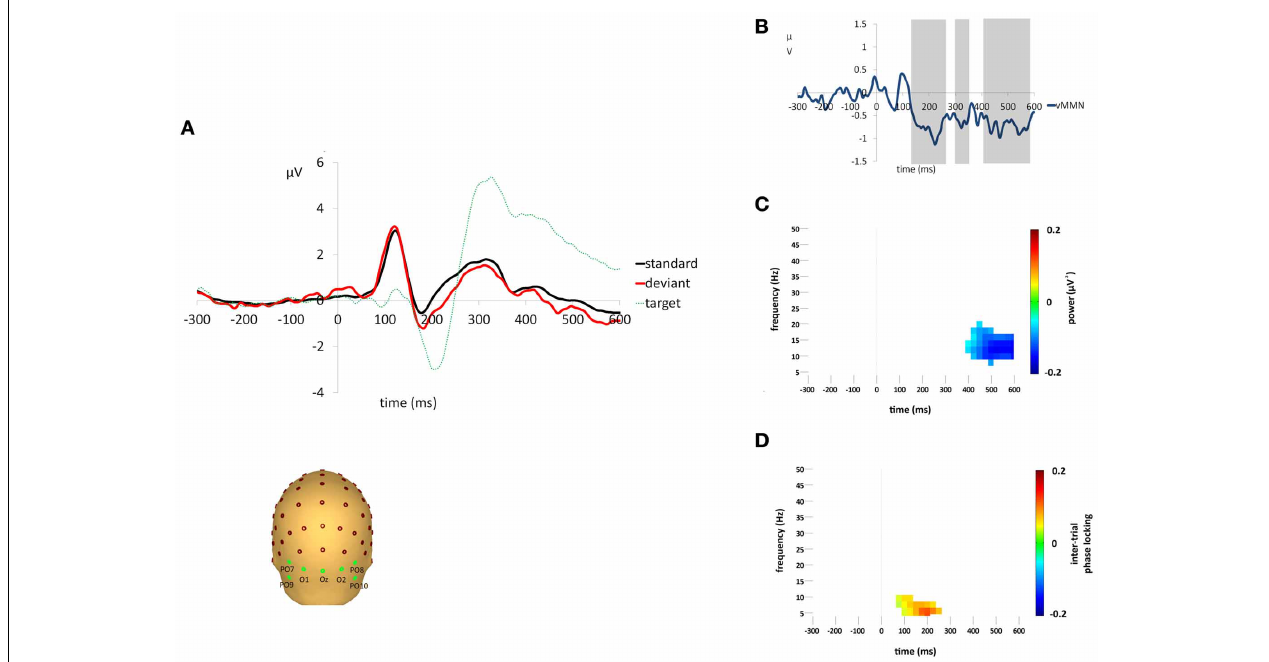
FIGURE 2 | (A) Grand average responses to standard, deviant and target stimuli measured at the occipital region of interest. Electrodes O1,Oz,O2,PO9,PO10,PO7,and PO8 were averaged to form the occipital region of interest for VEP analyses. (B) Difference waveforms (i.e., deviant minus standard) illustrating the vMMN response. Shaded areas indicate epochs of significant difference ( p < 0 . 05) between responses to standard and deviant stimuli. (C) Difference (i.e., deviant minus standard) in non-phase-lockedspectral powerchange ( μ V 2 ) comparedto baseline ( − 300to 0ms) for the average activity across the occipital region of interest. Plot